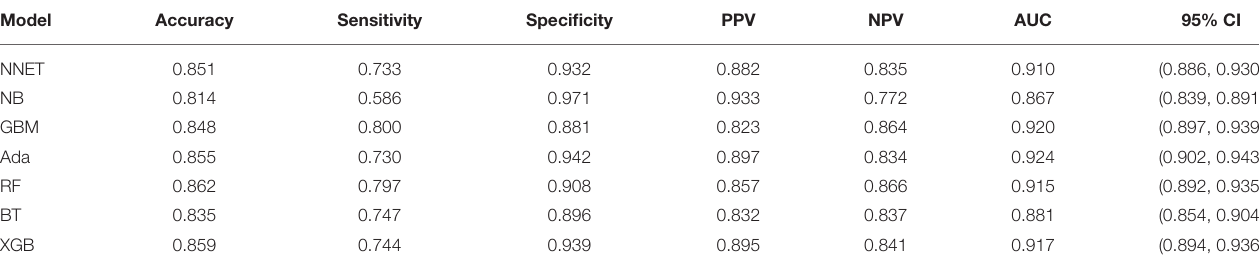
TABLE 2 | Prediction performance of the machine learning models in the testing set. Model